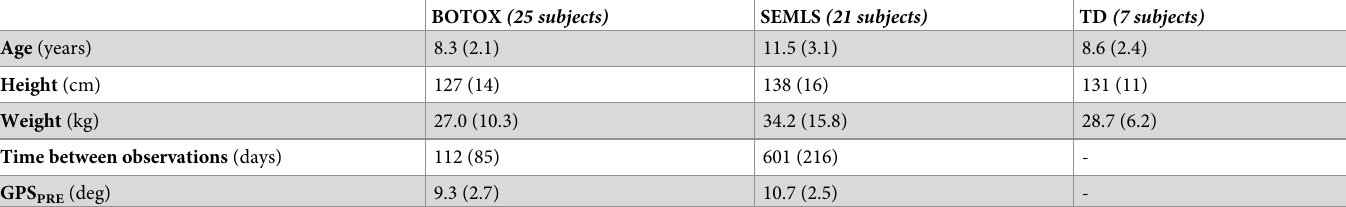
Table 1. Demographics of the participants of the study. Values are reported as mean (standard deviation). GPS PRE stands for pre-treatment gait profile score, with higher scores indicating more deviation from normal